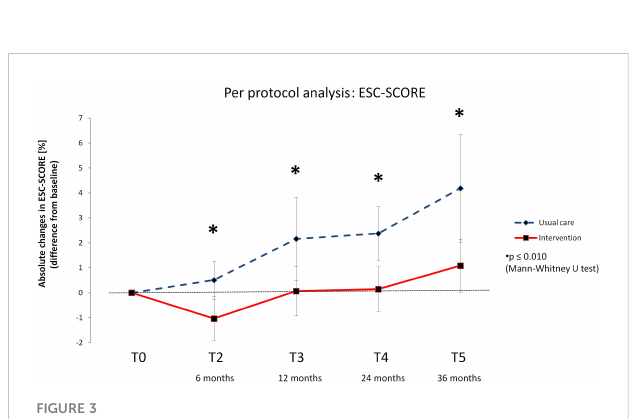
FIGURE 3 Delta values of the European Society of Cardiology – Systematic Coronary Risk Evaluation score (ESC-SCORE) – Per protocol analysis. Means with 95% con fi dence intervals.